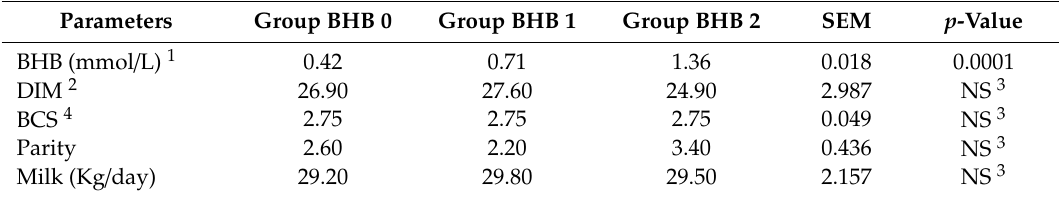
Table 2. Mean value ( ± SEM) of β -hydroxybutyrate (BHB), days in milk (DIM), Body Condition Score (BCS), parity, and daily milk